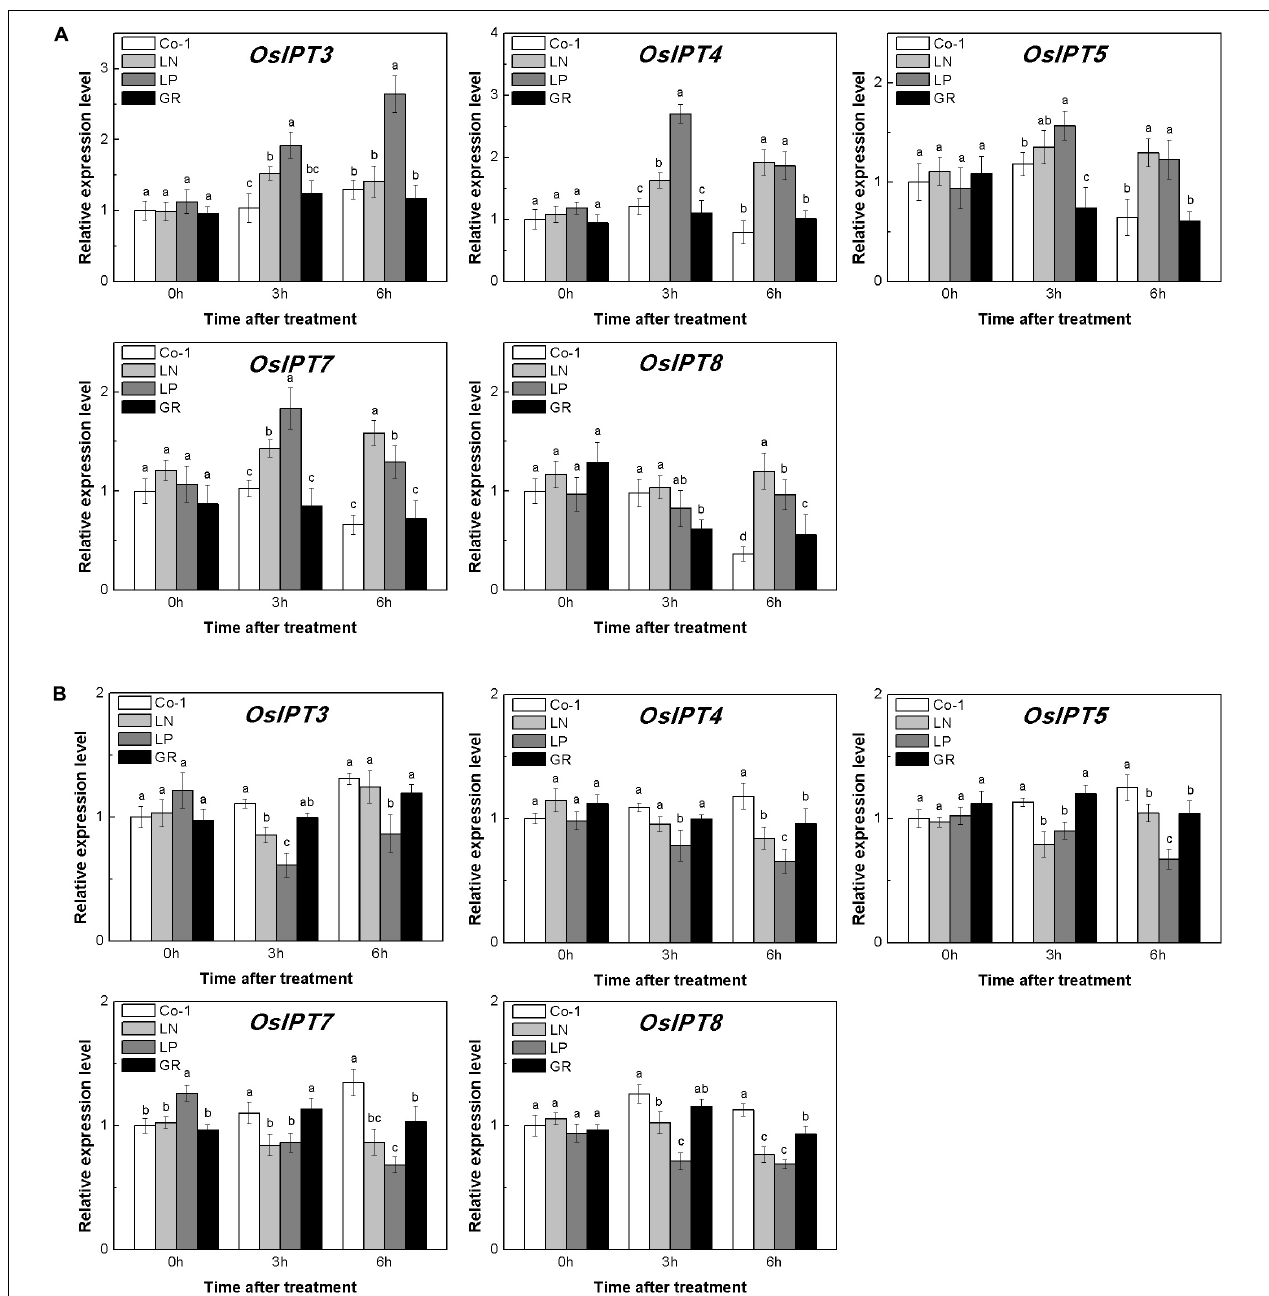
FIGURE 4 | Expression patterns of OsIPT3 , OsIPT4 , OsIPT5 , OsIPT7, and OsIPT8 CK biosynthesis genes in rice tiller buds (A) and tiller nodes (B) located at the fifth leaf axils expressed in response to the treatment. Total RNA was isolated from less than 0.1 g of buds and nodes each time. β -Actin was used as a reference gene. The value obtained from the control treatment at 0 h after treatment was arbitrarily set at 1.0. Quantitative real-time PCR was performed in triplicate (three biological replicates), and mean values with SD are shown.